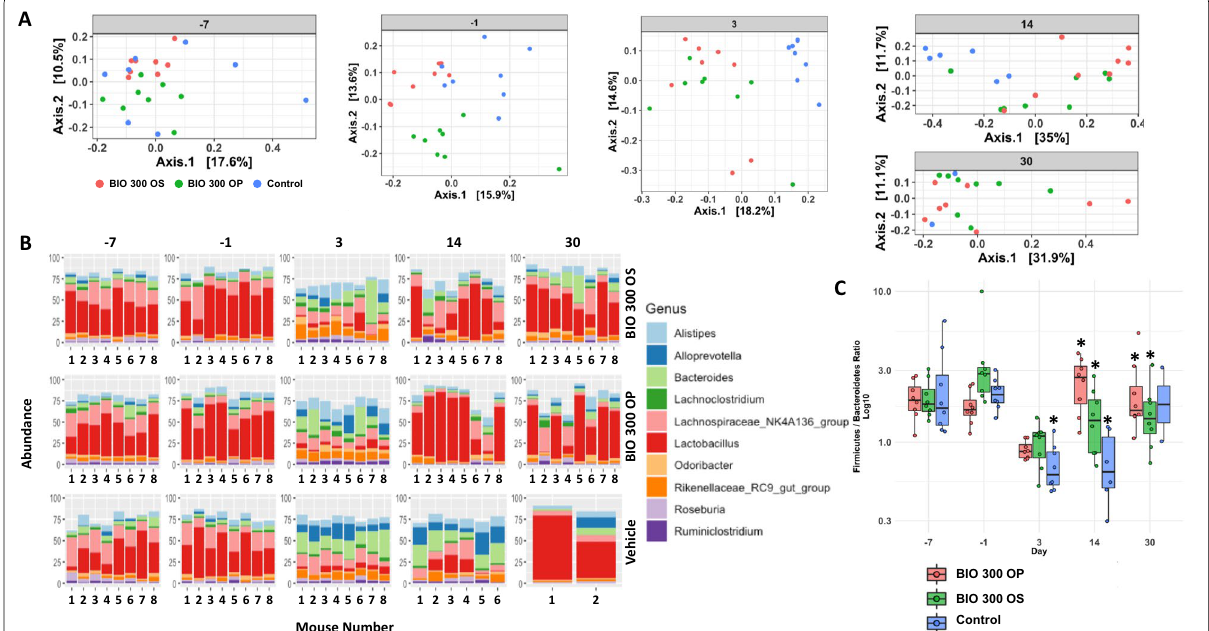
Fig. 3 Alterations in radiation-induced microbiome diversity were alleviated by BIO 300 by day 14. Panel A Principal Coordinate Analysis showing clustering patterns for control mice and the treatment groups at 7 day and 1 day before irradiation as well as days 3, 14, and 30 post-irradiation. Panel B Relative abundance of the top 10 most abundant genera for the same cohort of mice across different treatment groups and time points. Panel C Log 10 Firmicutes/Bacteriodetes ratio over time between the three groups: BIO 300 OP, BIO 300 OS, and